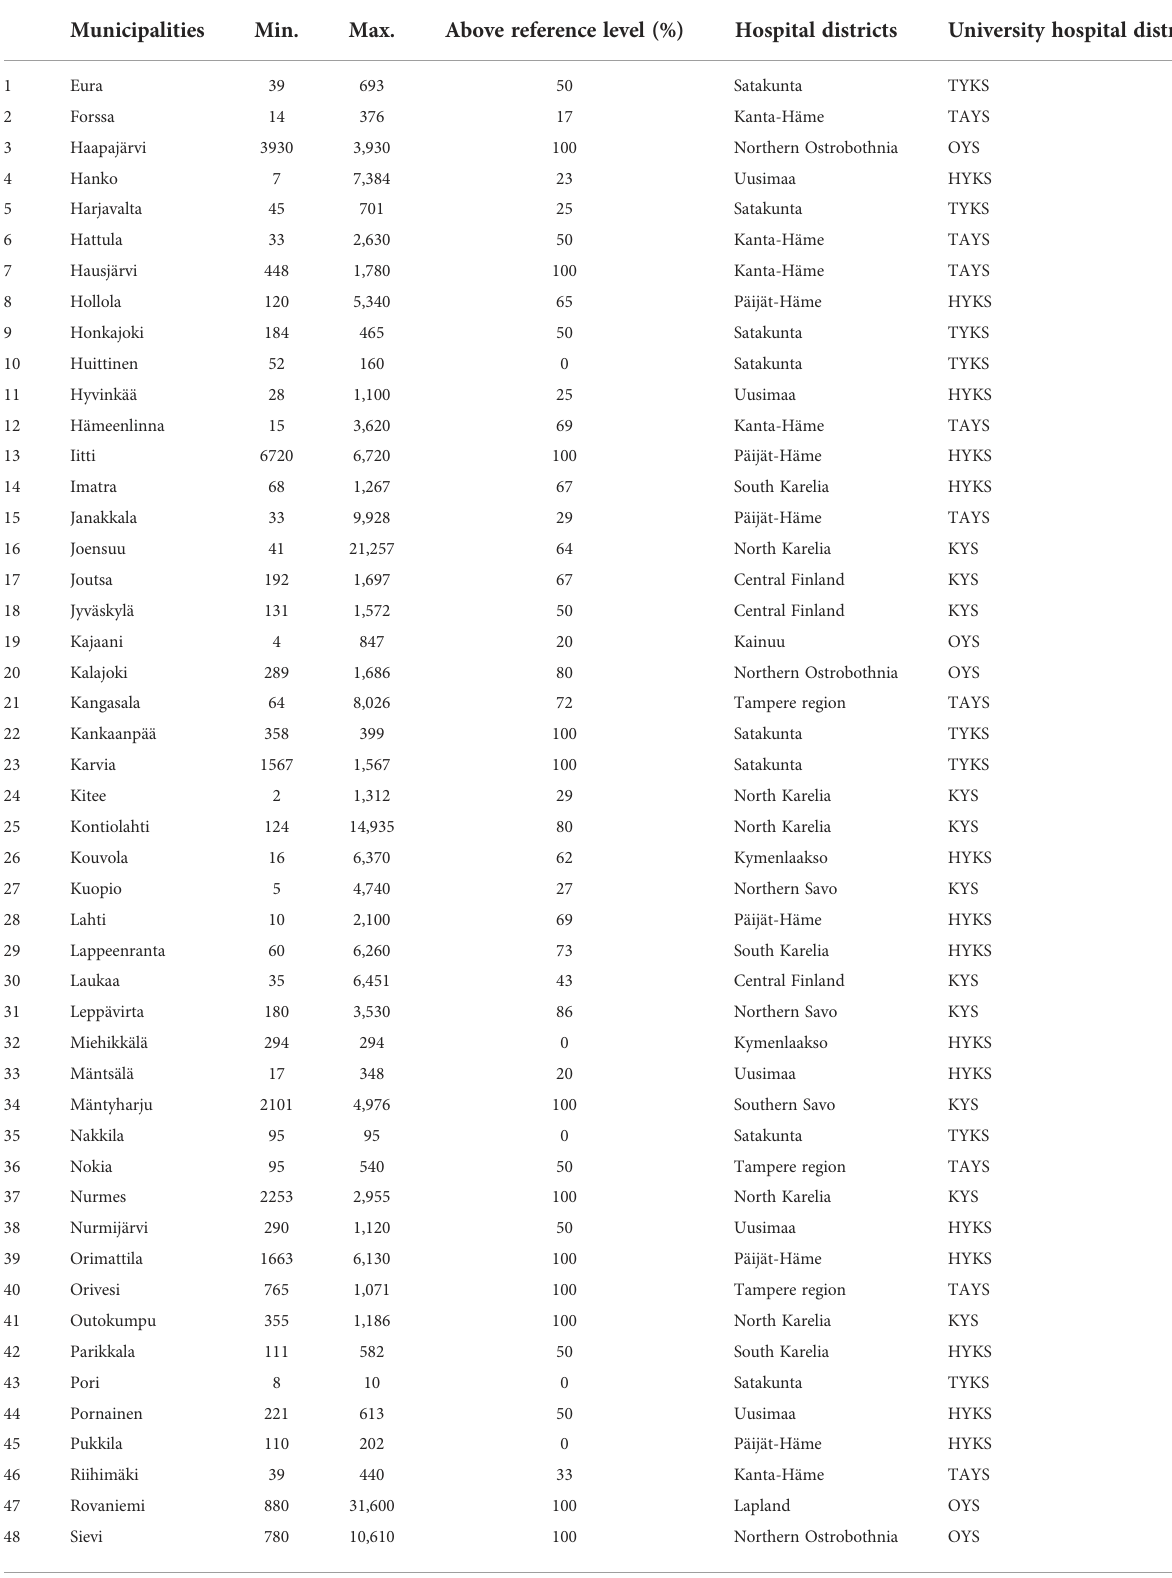
TABLE 1 Concentrations of indoor air radon at groundwater treatment plants in Finnish municipalities in 2020. Municipalities Min.